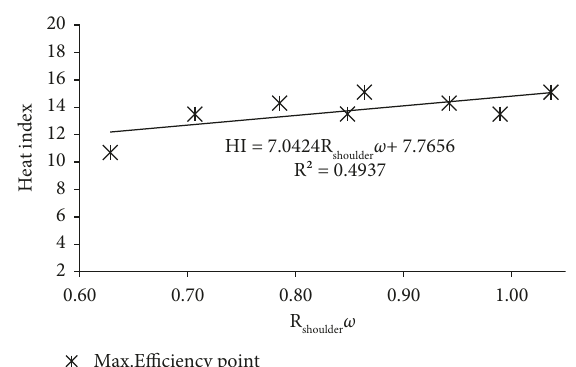
Figure 7: Heat index for the chosen tool shoulder radius and rotational